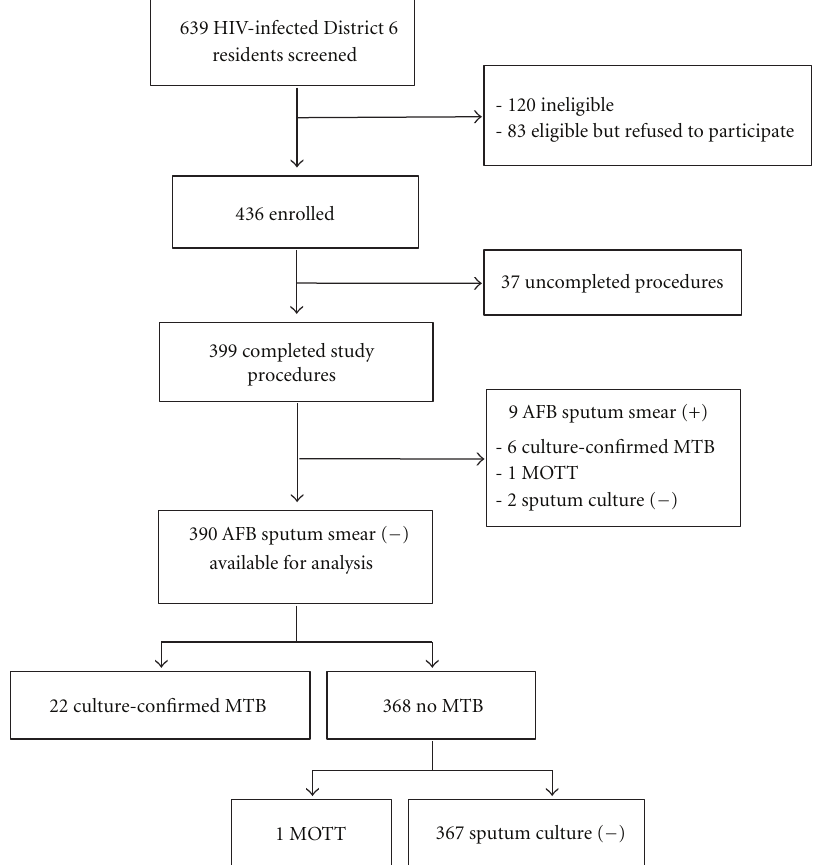
Figure 1: Patient enrollment flow chart. AFB-positive: having at least one AFB-positive sputum smear. AFB-negative: having both AFB- negative sputum